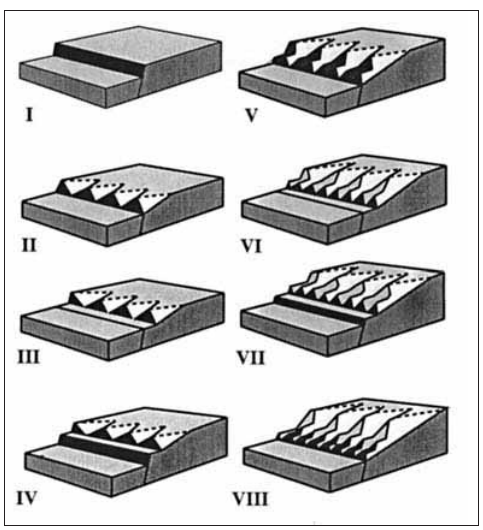
Fig. 7. Development of faceted spurs produced by episodic vertical tectonic movement. I - undissected fault scarp. II - development of faceted spurs by streams cutting across the fault scarp. III - period of tectonic quiescence with slope retreat, and develop- ment of a narrow pediment. IV - renewed fault movement. V - dissection of the new fault scarp by major streams and streams developed on the faces of the faceted spurs developed at stage II. VI - a new period of tectonic quiescence, with the development of another narrow pediment within the footwall block at the base of the range front. VII - renewed fault movement. VIII - dissection of the fault scarp produced at stage VII resulting in a line of small faceted spurs at the base of the range front. Remnants of narrow pediments (benches) are pre- served at the apices of each set of faceted spurs. Progressive slope retreat is accompanied by a decrease in the slope angle of the faceted spurs. Modified from Hamblin